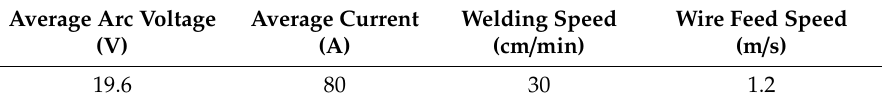
Table 2. The operational parameters of the welding experiment.